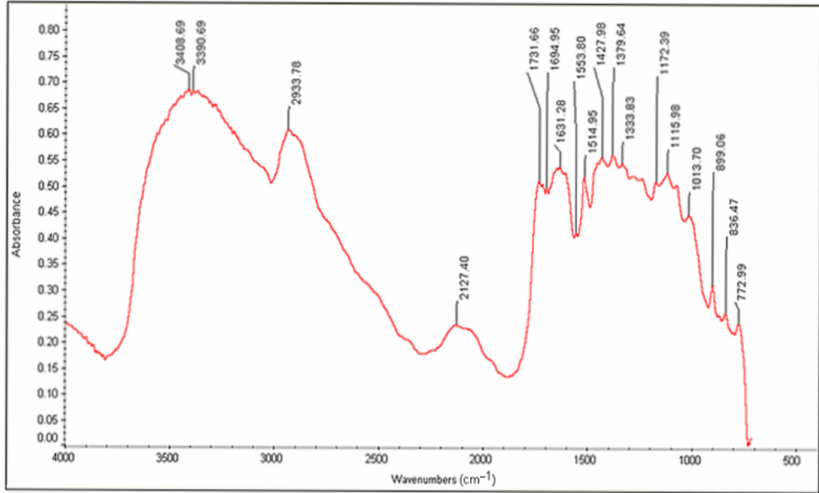
Figure 2. FT-IR spectrum of the natural